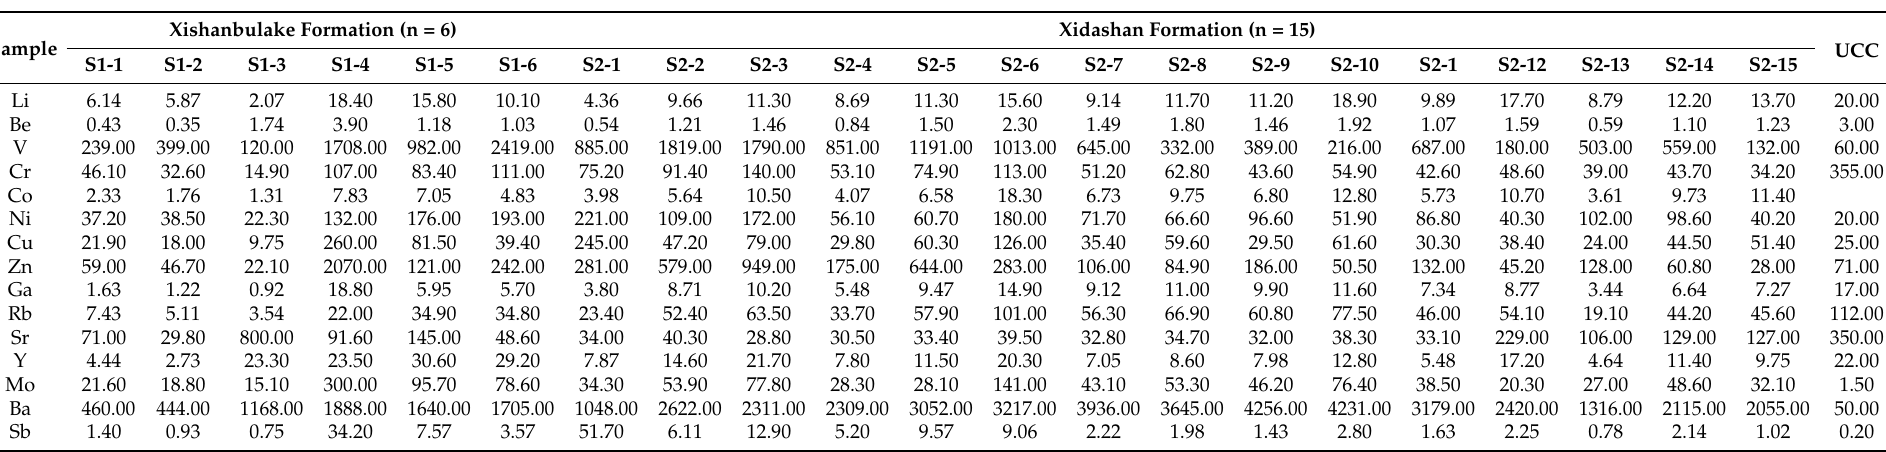
Table 2. Trace element concentrations (in µ g/g) for Lower Cambrian mudstones in the study